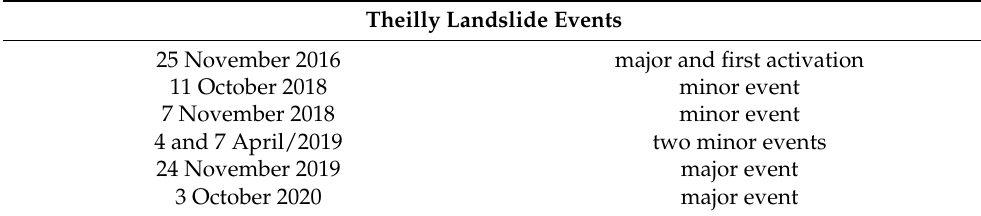
Table 3. Theilly landslide reactivation events.